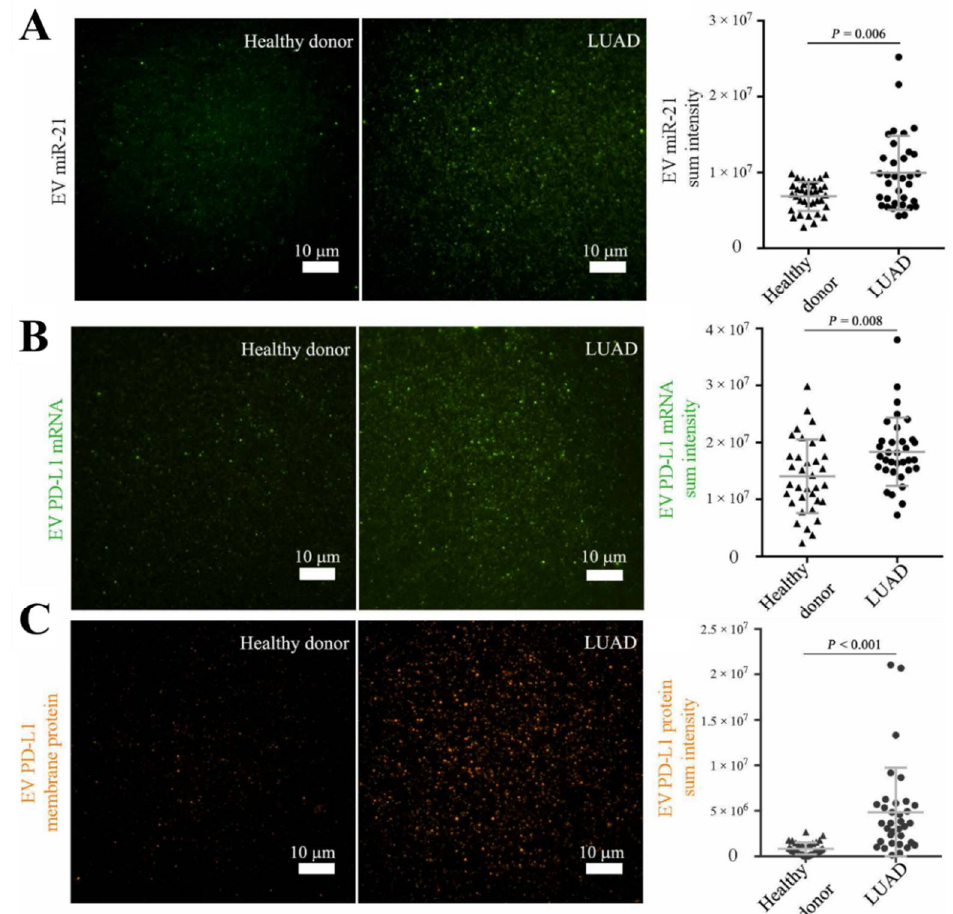
Figure 13. Measurement of the different EV cargo biomarker expressions. Representative images and analysis of the ( A ) EV miR-21, ( B ) EV PD-L1 mRNA and ( C ) EV PD-L1 membrane protein. Reprinted with permission from [110]. Copyright 2020, American Association for the Advancement of Science.